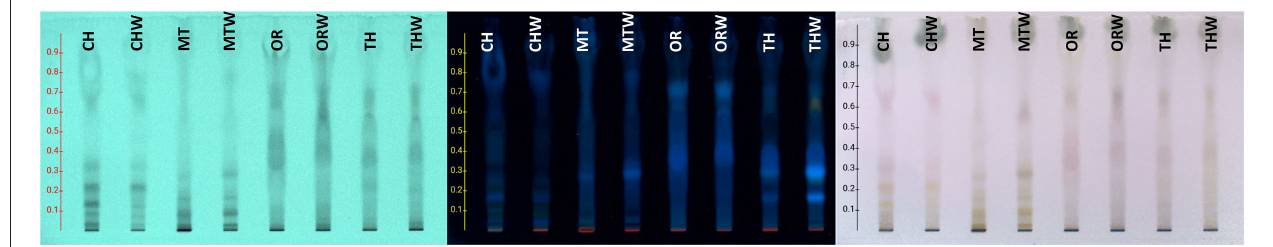
FIGURE 1 | High-performance thin layer chromatography (HPTLC) of hydroalcoholic extracts of chamomile (CH, superior plant material; CHW, inferior plant material), Greek mountain tea (MT, superior plant material; MTW, inferior plant material), oregano (ORV, superior plant material; ORVW, inferior plant material), and thyme (THV, superior plant material; THVW, inferior plant material), on a reversed phase TLC plate and H 2 O:ACN:A.A: (80:20:1) as a mobile